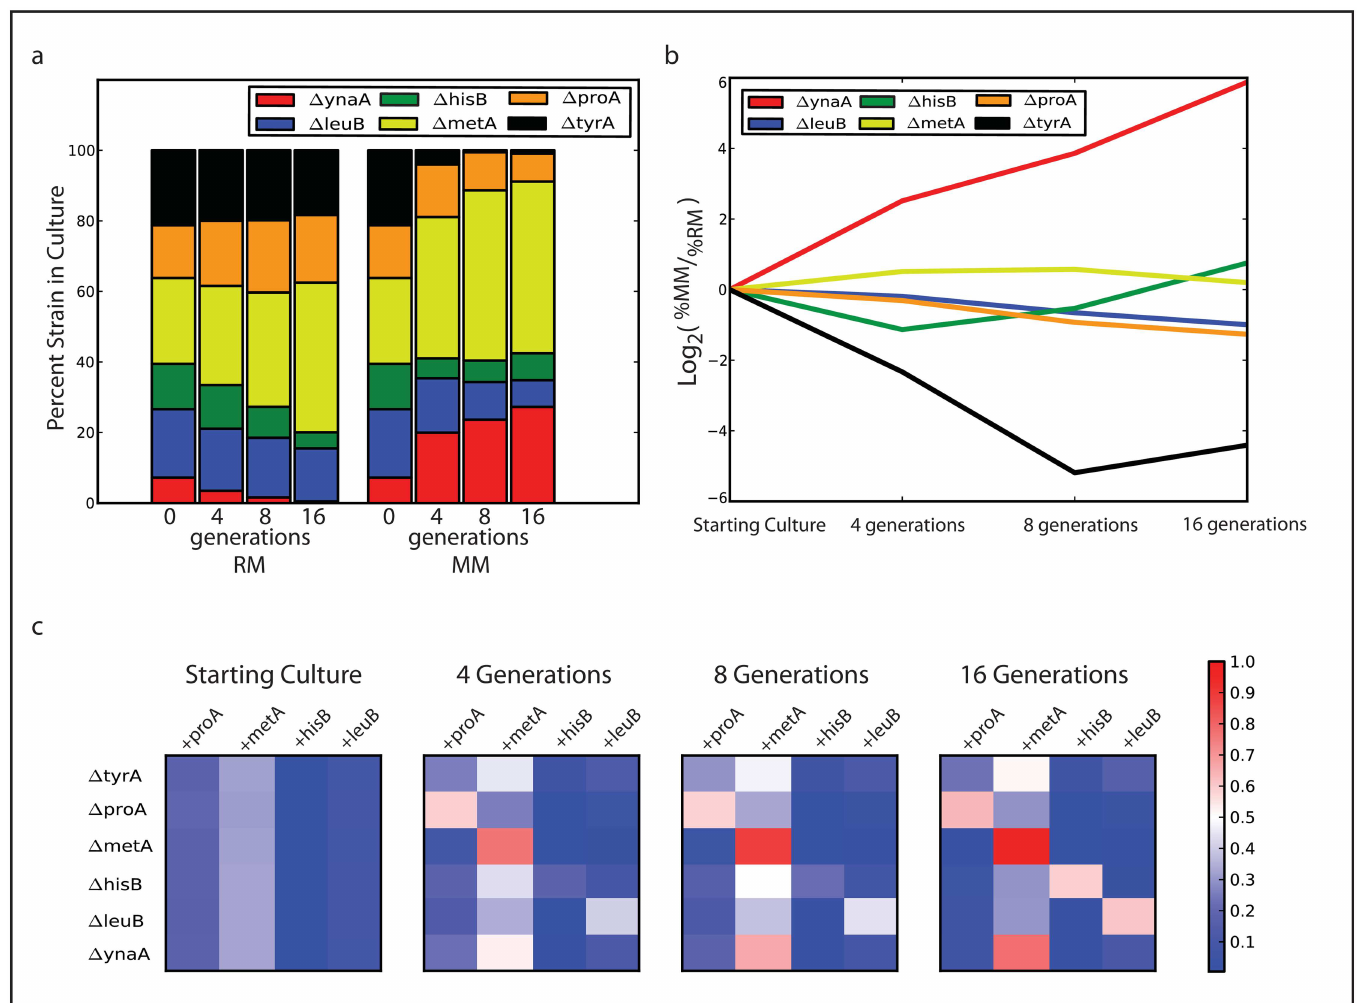
Fig 4. Screening a combinatorial library of amino acid auxotrophy with sc-Seq. (a) The membership(by strain) of heterogeneous cultures is tracked by droplet scLPCR for cultures grown in rich media (RM) or minimalmedia (MM) at 0,4,8, or 16 doublingsafter inoculation. (b) The fractional fold change in minimalmedia vs. rich media over 16 doublingsshows that auxotrophic strains with no complementdrop out of the population( Δ tyrA, black line) while prototrophicexperience no selectionand take over ( Δ ynaA, red line). (c) DropletscLPCR shows the culture composition by strain and plasmid and unmasks the mechanism of complementation, wherebyauxotrophic strains persist in the culture through selective outgrowthof only those strains that harbor the corresponding complementary gene(color correspondsto fraction of sequencing reads within each strain that are specific for the correspondingcomplement